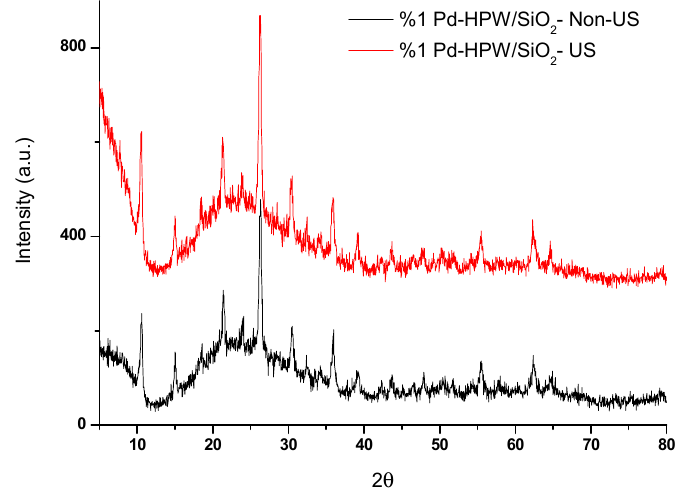
Figure 2. XRD analysis of the ultrasonically and non-ultrasonically synthesized Pd-HPW/SiO 2 .